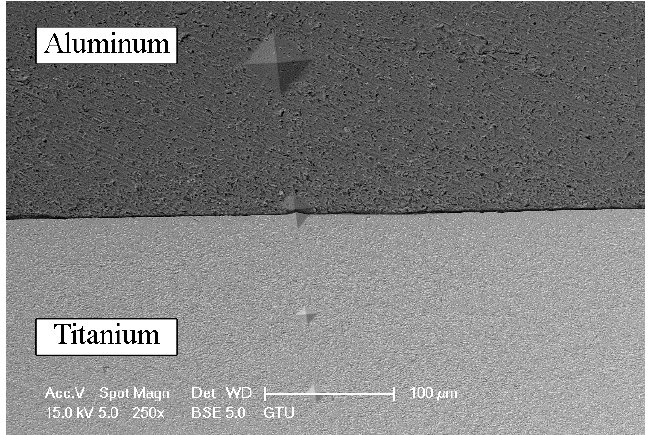
Figure 3. Microhardness measurement marks with SEM.